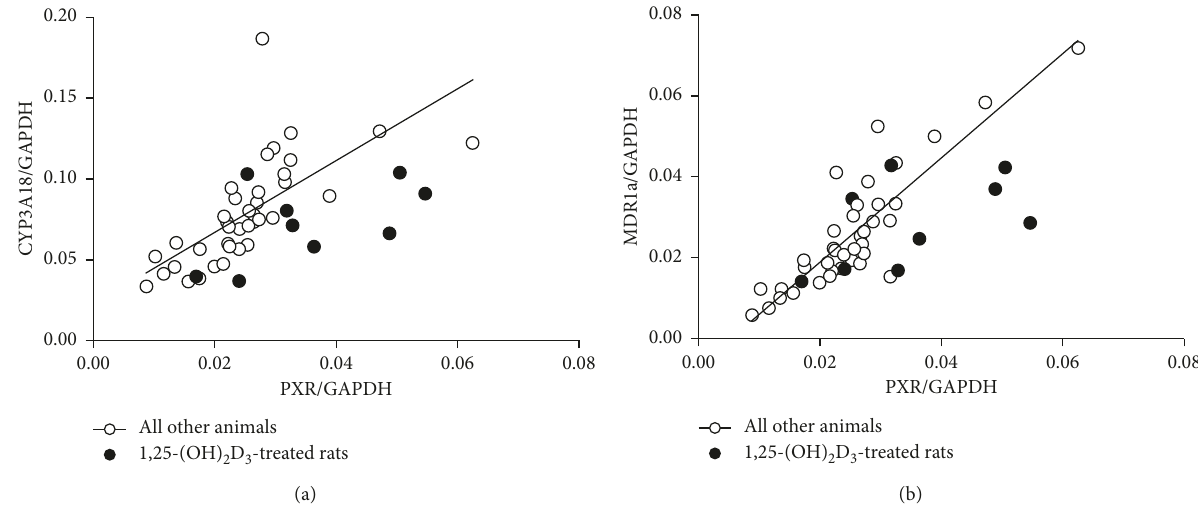
Figure 1: Regression analyses revealing linear correlations between the expression of PXR and CYP3A18 ( y � 2.220 ± 0.391 x –0.022 ± 0.011, r 2 : 0.47, P < 0 . 001) and MDR1a ( y � 1.290 ± 0.121 x –0.007 ± 0.003, r 2 : 0.75, P < 0 . 001) in the proximal jejunum in all groups except for rats treated with 0.5 μ g/kg body weight 12h before